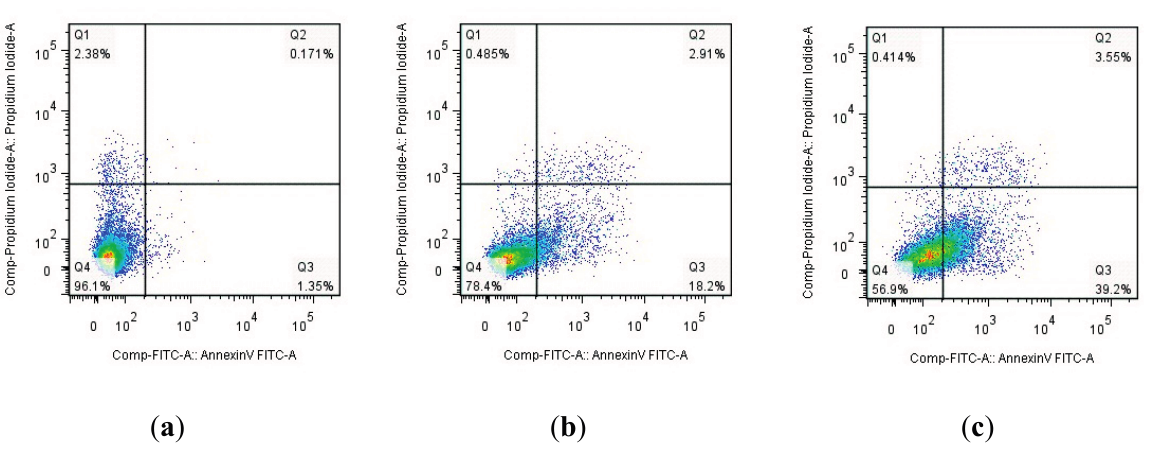
Figure 5. Apoptosis ratio detection of compound 9n by Annexin V/PI assay. ( a ) Cells not treated with compund 9n were used as control for 12 h; ( b , c ) HeLa cells were treated with compound 9n at 10 and 15 μ M for 12 h, respectively.